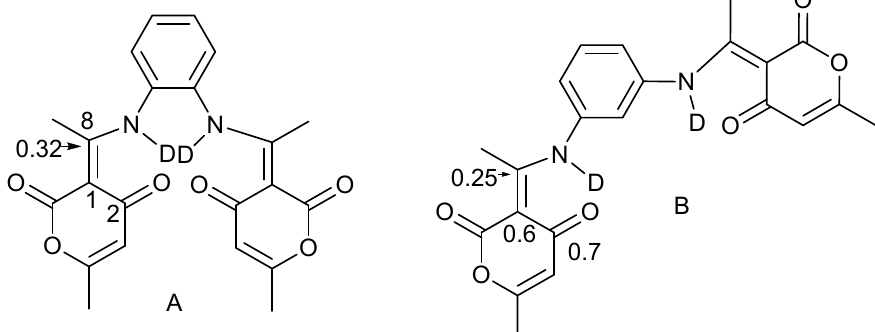
Figure 10. Two-bond deuterium isotope effects on 13 C chemical shifts in ppm of phenylenediamine derivatives of dehydracetic acid deuterated. ( A ) Derivative based on o- phenylene diamine; ( B ) Derivative based on m-phenylene diamine Data from Ref. [28].